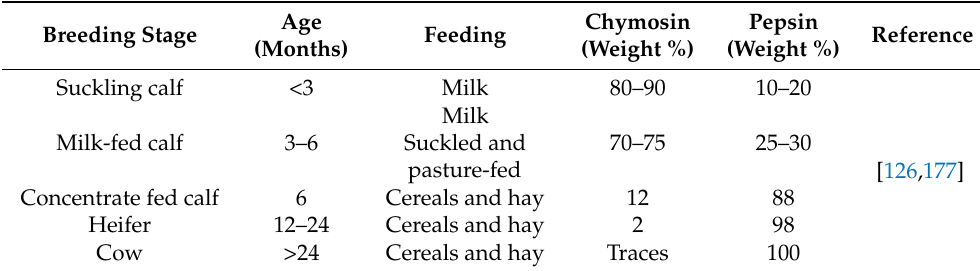
Table 3. The ratio between chymosin and pepsin in the bovine abomasal mucosa, depending on the age and feeding